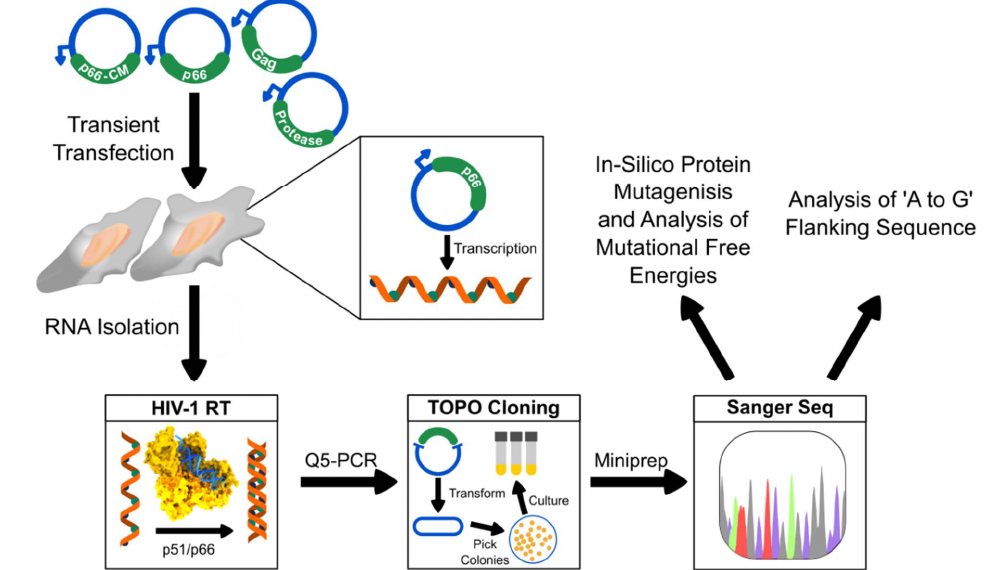
Figure 1. A schematic diagram outlining the workflow of the in vitro selection pressure free HIV-RT fidelity assay. Vectors containing HIV-1 Gag, protease, RT p66, and Codon Mutated RT were transiently transfected into EXPI293F cells. Total RNA was extracted and subjected to HIV-RT cDNA synthesis followed by Q5 PCR amplification for TOPO blunt-end cloning and the sequence that was analyzed. Mutants were subjected to computational analysis with respect to their mutational free energies and flanking sequences of ‘A to G’.